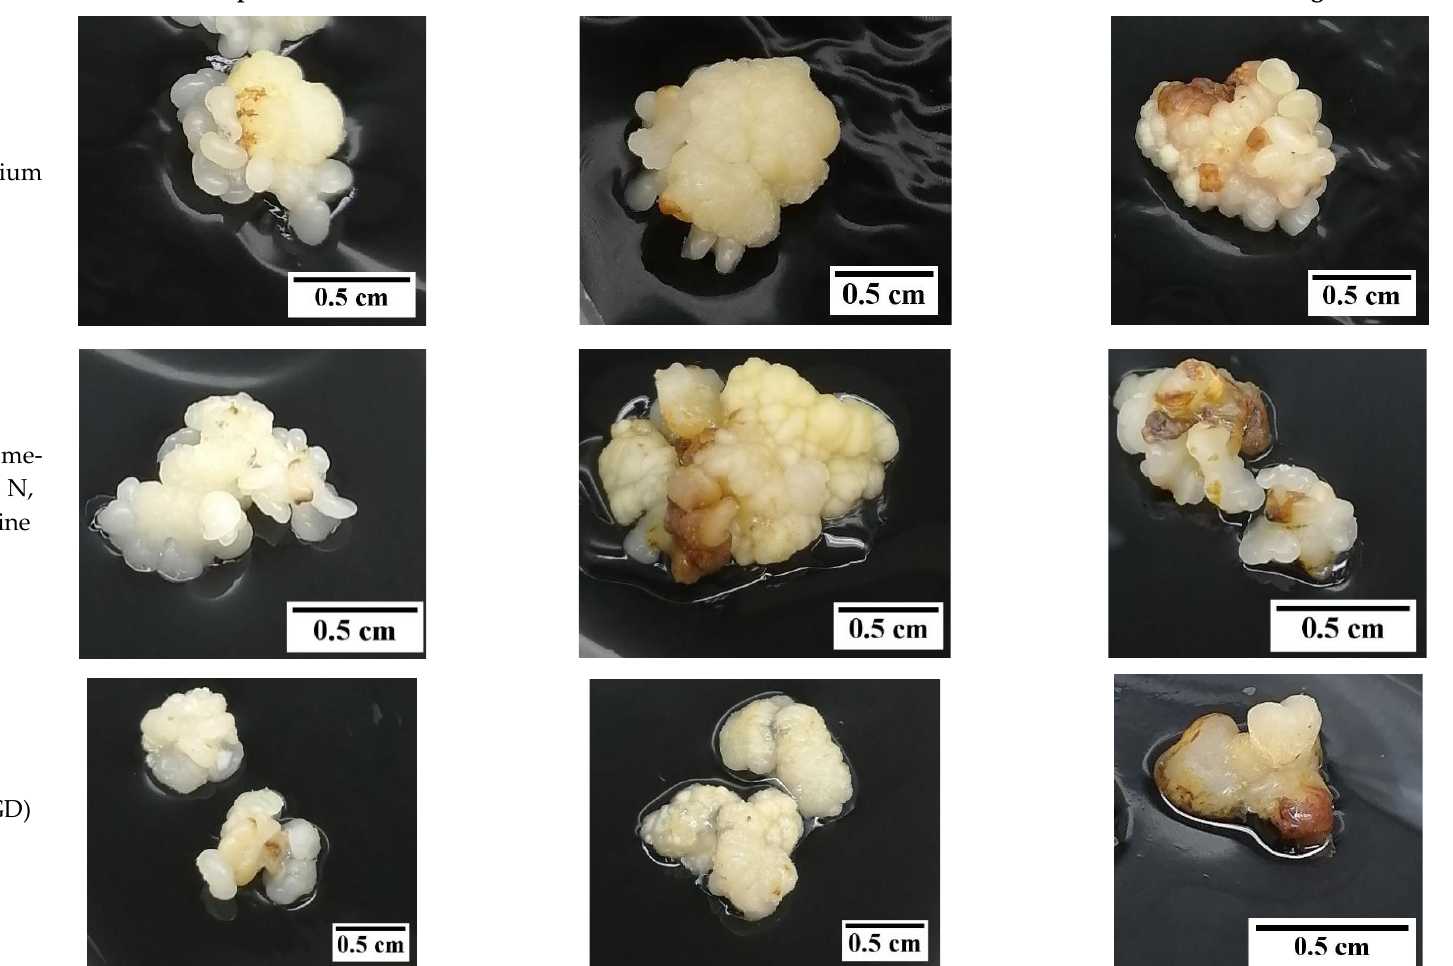
Figure 9. The effect of reduced nutrient concentration on the formation of compact embryogenic callus (EC), non-embryogenic callus (non-EC), and browning callus for the variety Sampoorna.